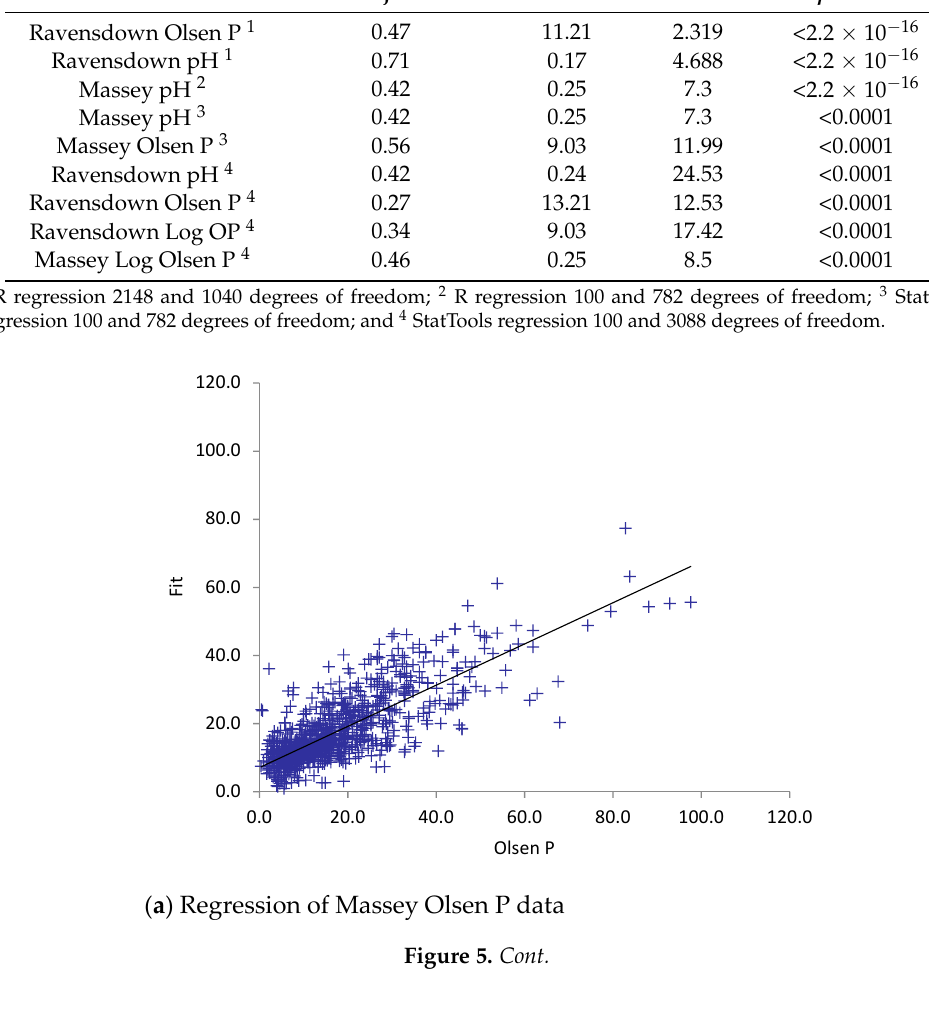
Table 2. Summary of regression